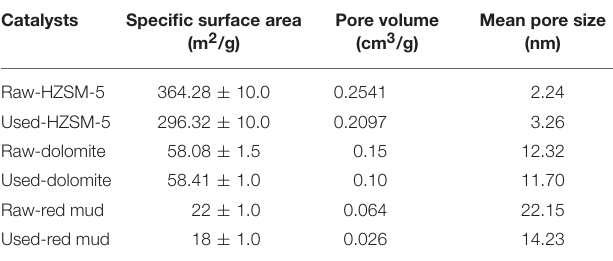
TABLE 3 | Porous texture of the catalysts before and after